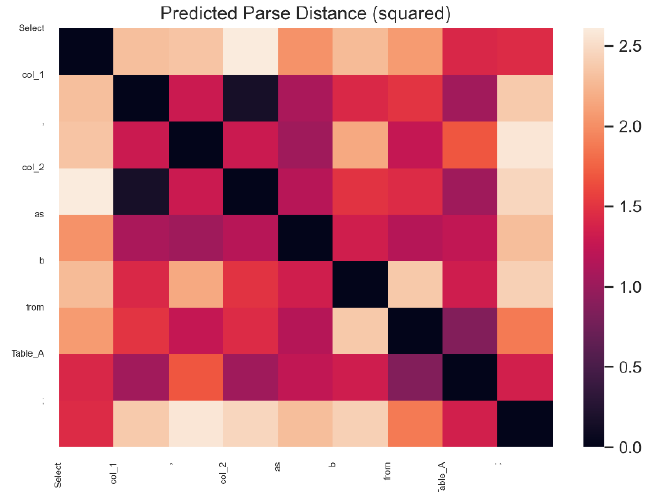
Figure 6. Predicted parse depth. The horizontal coordinate is the position of the word in the SQL statement, and the vertical coordinate is the depth (relative value) of the word in the syntax tree learned by the model. It can be seen that the depth of the syntax tree computed by the synBERT model is similar to the actual value.